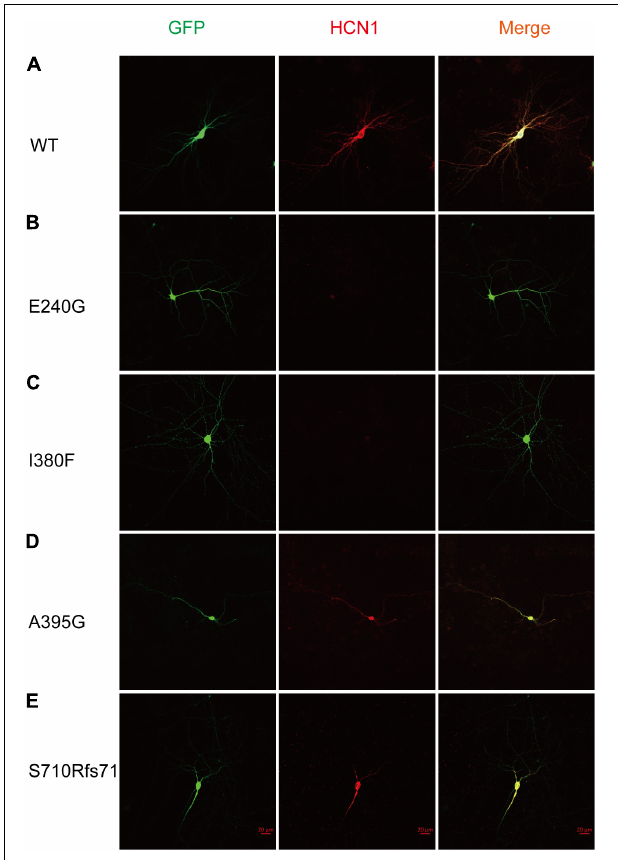
FIGURE 6 | Mutant HCN1 channels distributed differently in cortical neurons. (A–E) The expression of WT ( n = 13), E240G ( n = 7), I380F ( n = 9), A395G ( n = 9), and S710Rfs*71 ( n = 9) channels in cortical neurons, respectively.